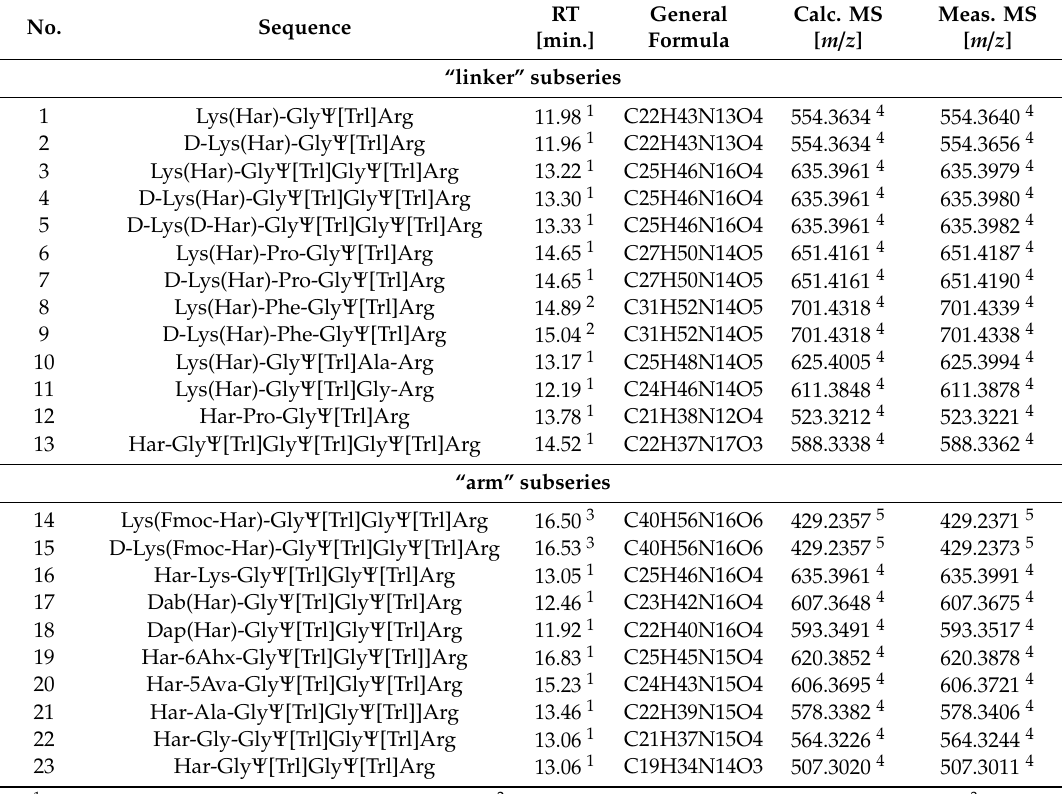
Table 1. Systematic characterization of synthesized triazolopeptides 1 – 23 .